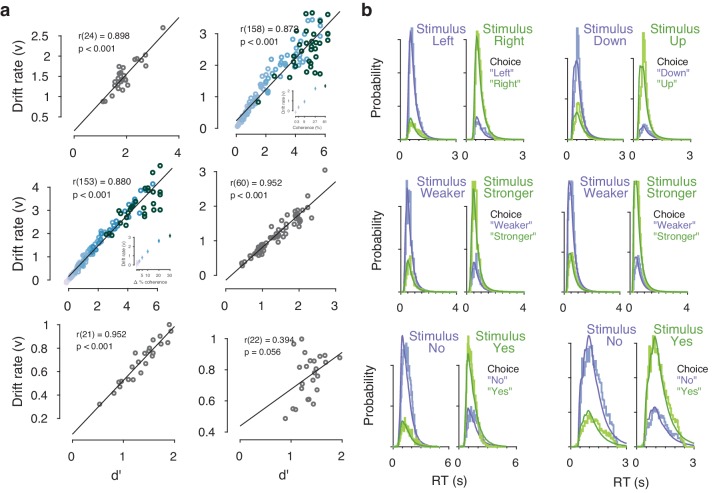
Drift diffusion model fits.(a) Correlation between drift rate (v) and d’. In the two datasets with multiple stimulus difficulty levels (Visual motion 2AFC (FD) and Visual motion 2IFC (FD) #1), drift rates were estimated separately for each level of stimulus difficulty. In these two datasets, the correlation coefficient displayed is a partial correlation between vand d’, while accounting for stimulus difficulty (inset, colors indicate discrete stimulus difficulty levels). As expected, the mean drift rate increased monotonically as a function of evidence strength. (b) Measured and predicted RT distributions, across all trials and observers within each dataset. Observed (light) and predicted (dark) RT distributions are separately shown for each combination of stimulus and choice (green/purple), with the low-probability distributions indicating error trials.